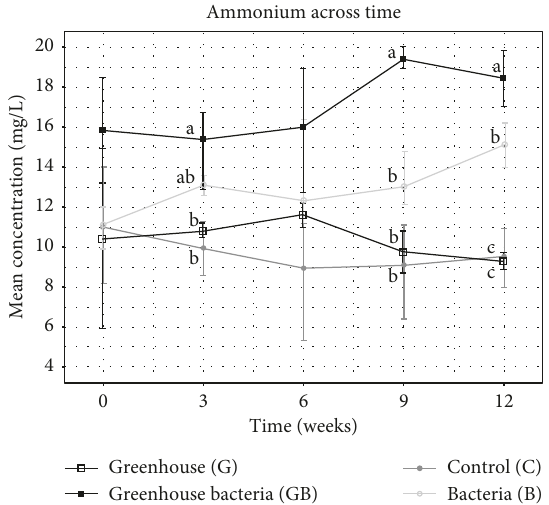
Figure 5: Nitrate concentrations per treatment across time. Means within a time measured followed by the same letter are not sig- nificantly different according to the Tukey–Kramer test or Nemenyi test in case of no